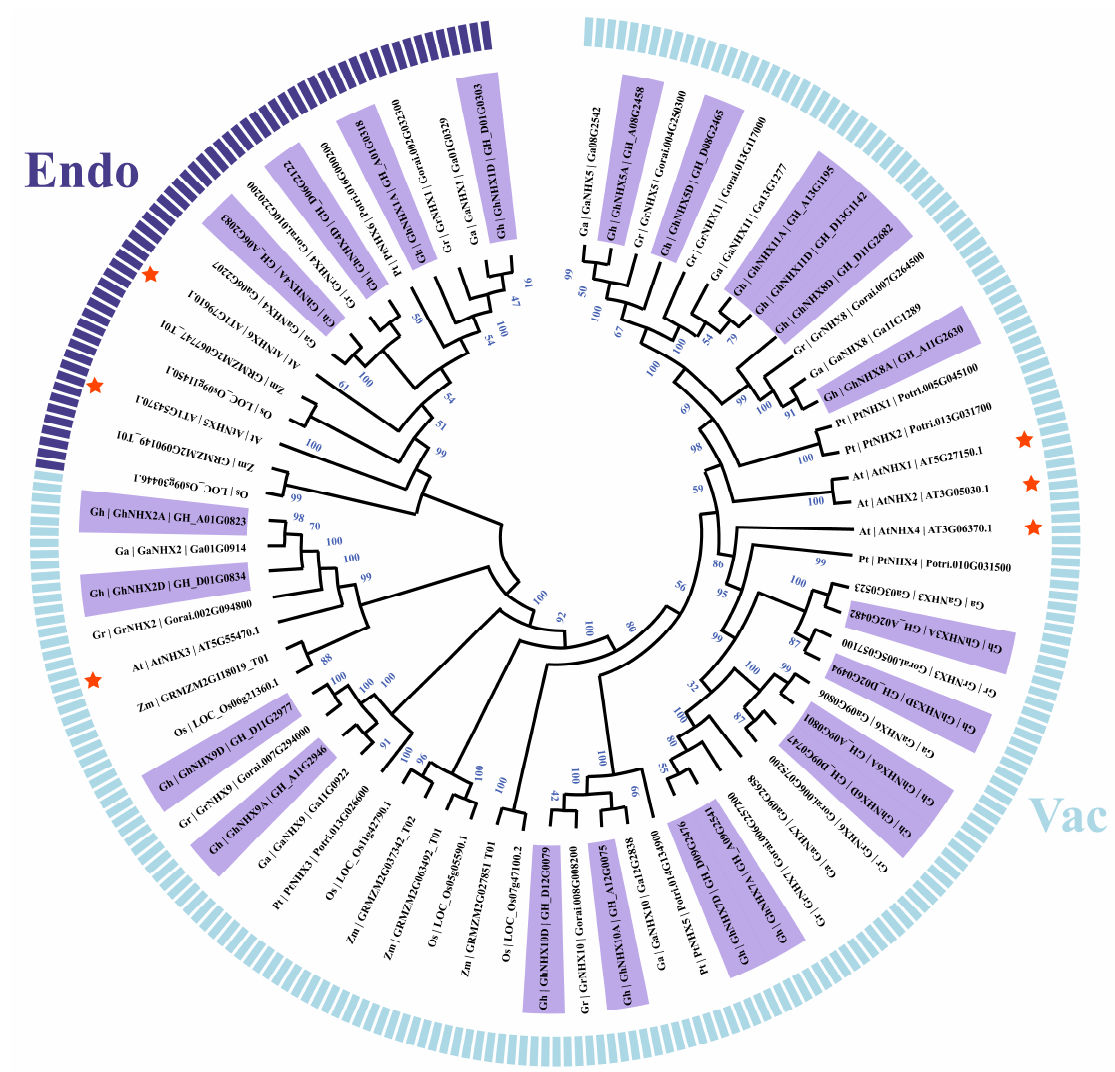
Figure 1. Phylogenetic analysis of the Na + / H + antiporters (NHXs). The phylogenetic tree was generated with the neighbor-joining method of MEGA X (1000 bootstrap replicates) using 22 NHXs from G. hirsutum (Gh) (Table S2) and 49 NHXs from G. arboreum (Ga), G. raimondii (Gr), A. thaliana (At), P. trichocarpa (Pt), O. sativa (Os), and Z. mays (Zm) (Tables S4 and S5). The NHXs from G. hirsutum are presented by purple backgrounds, and the NHXs from A. thaliana are indicated by red stars. All NHXs are classified into one of two classes (Class 1: vacuolar-type, Class 2: endosomal-type), which are differentiated by different color arcs. Numbers on the branches are bootstrap values.